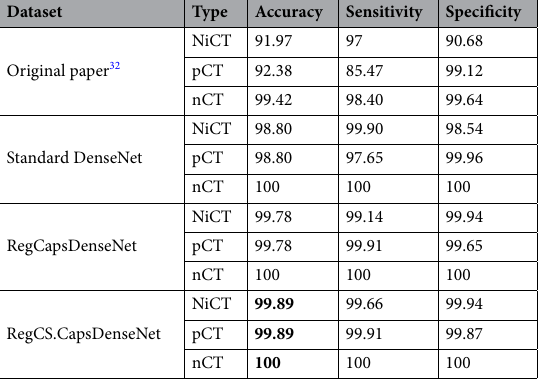
Table 1. Performance evaluation (%) of our developed deep networks on the HUST dataset compared to the original paper. The highest accuracy is shown in